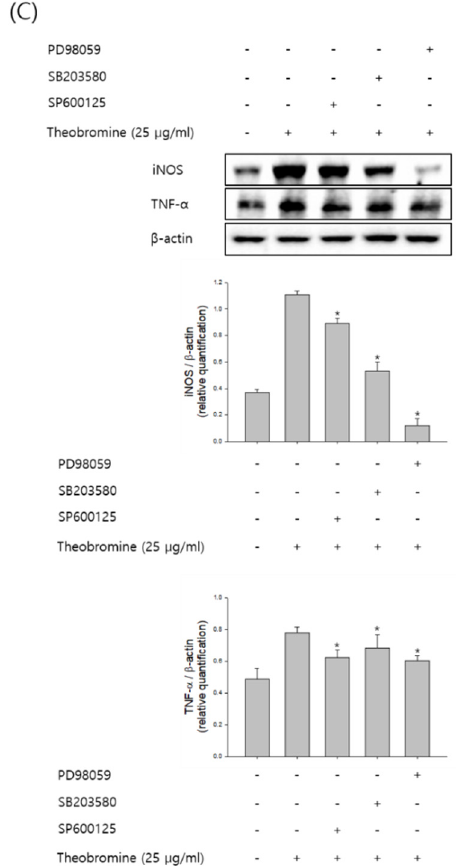
Figure 5. Effect of theobromine on the phosphorylation of MAPKs in RAW 264.7 macrophages. Macrophages were treated with theobromine for the various times and at the indicated concentrations. ( A , B ) The phosphorylation level of MAPKs was detected at the indicated times or concentrations by Western blot assay to confirm the MAPKs phosphorylation. ( C ) Macrophages were treated with theobromine for 1 h in the presence or absence of the ERK1/2 inhibitor PD98059 (10 µ M), the JNK inhibitor SP600125 (20 µ M), and the p38 MAPK inhibitor SB203580 (20 µ M). Whole cell lysates were analyzed by Western blot assay. β -actin protein levels were used as an internal control. Results are shown as means ± SEM of quintuplicates from a representative experiment. * p < 0.05, compared with the untreated group.